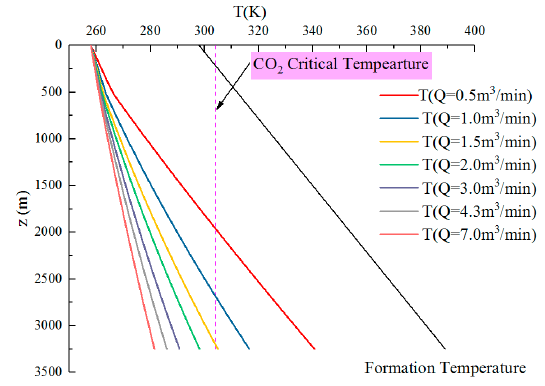
Figure 6. Temperature distribution under different displacement.